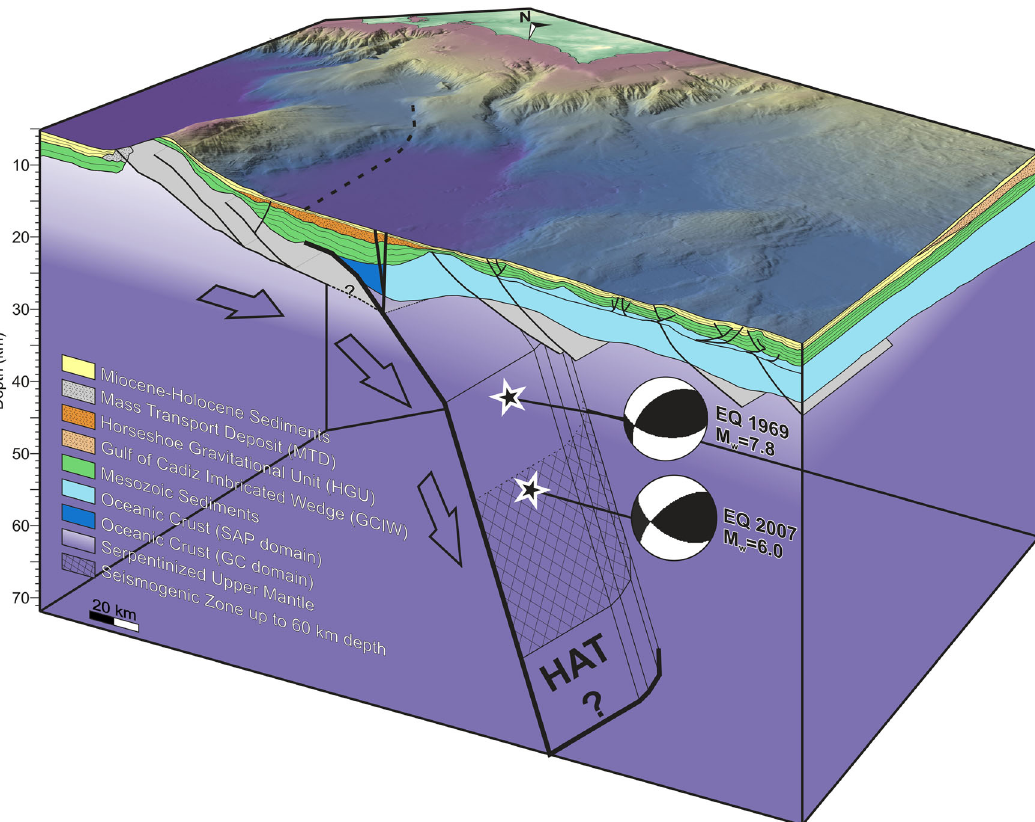
Fig. 2 The Horseshoe Abyssal plain Thrust (HAT) 3D scheme. The 3D regional tectonic and stratigraphic cross-section along pro fi le P1 (located in Fig. 1) showing the geometry of the HAT and the projection in depth of the 1969 M w 7.9 15,37 and 2007 M w 6.0 5,38 earthquakes (Supplementary Table 1). Serpentinization degree is indicated as gradation of